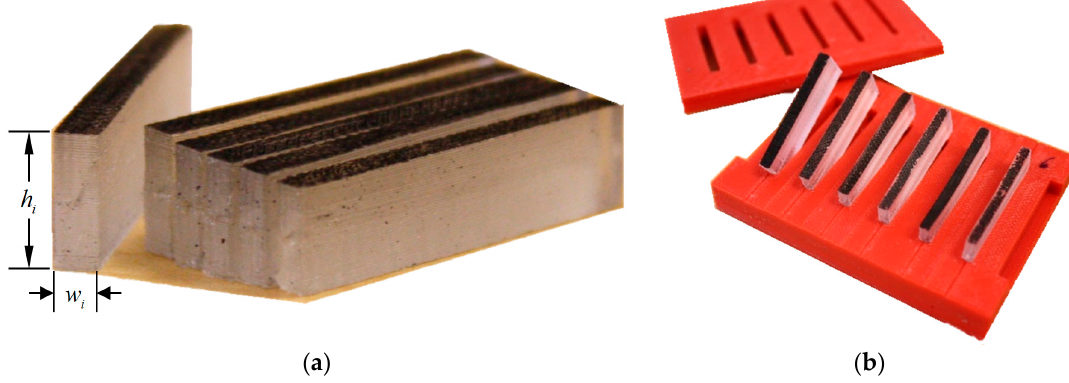
Figure 11. ( a ) Rectangular polydimethylsiloxane (PDMS) sleeves (edges highlighted in black for image contrast) with ( b ) molds used for fabrication.